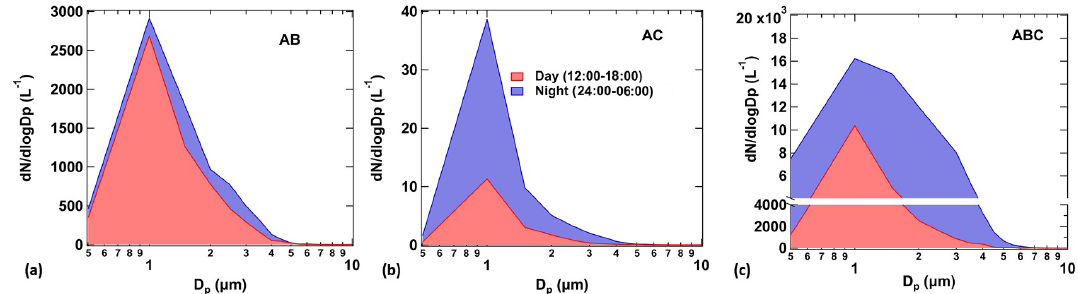
Figure 5. The size distributions of types (a) AB, (b) AC and (c) ABC were averaged from 12:00 to 18:00LT (red shading) and from 24:00 to 06:00LT (blue shading) for the 8d of the